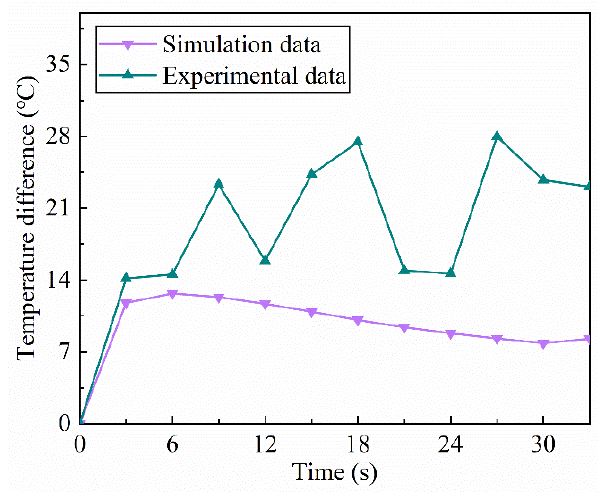
Figure 20. Temperature difference between points A and B.